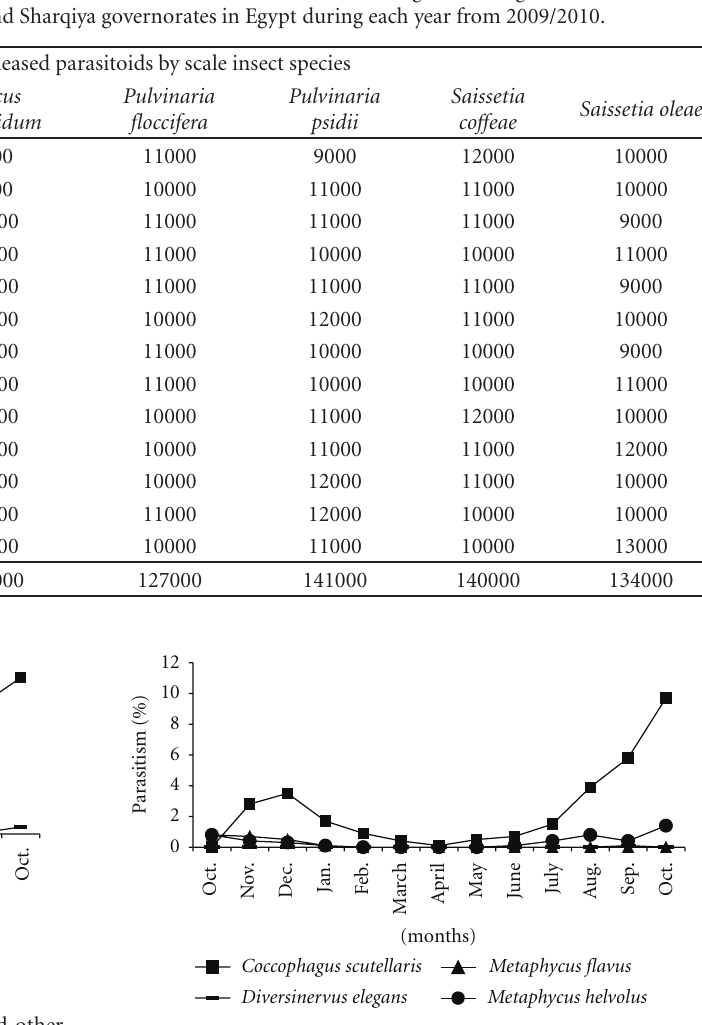
Table 1: Total numbers of the adult parasitoid Coccophagus scutellaris released in di ff erent fields of citrus, guava, mango, olive in Beni Seuf,